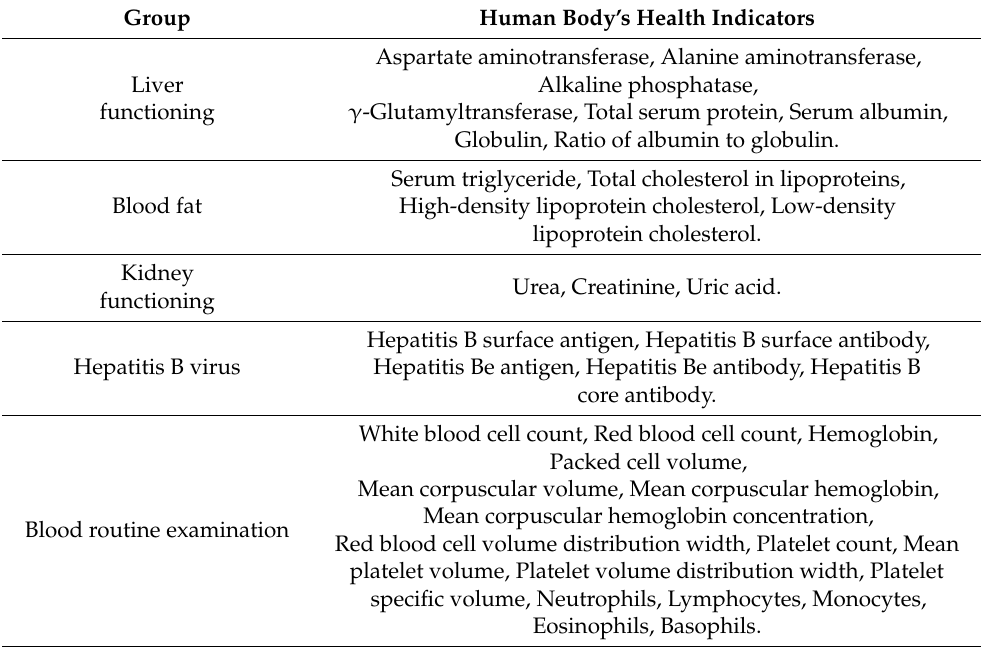
Table 2. Human body’s health indicators, divided into groups. Group Human Body’s Health Indicators Aspartate aminotransferase, Alanine aminotransferase, Liver Alkaline phosphatase, γ -Glutamyltransferase, Total serum protein, Serum albumin, functioning Globulin, Ratio of albumin to globulin. Serum triglyceride, Total cholesterol in lipoproteins, Blood fat High-density lipoprotein cholesterol, Low-density lipoprotein cholesterol. Kidney Urea, Creatinine, Uric acid. functioning Hepatitis B virus